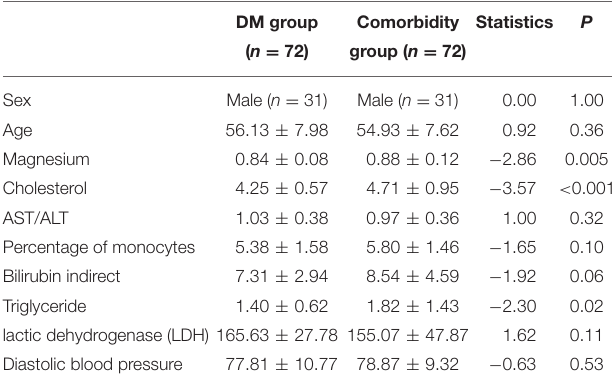
TABLE 2 | Demographics and biomarkers of experimental results of 144 diabetes mellitus patients with and without